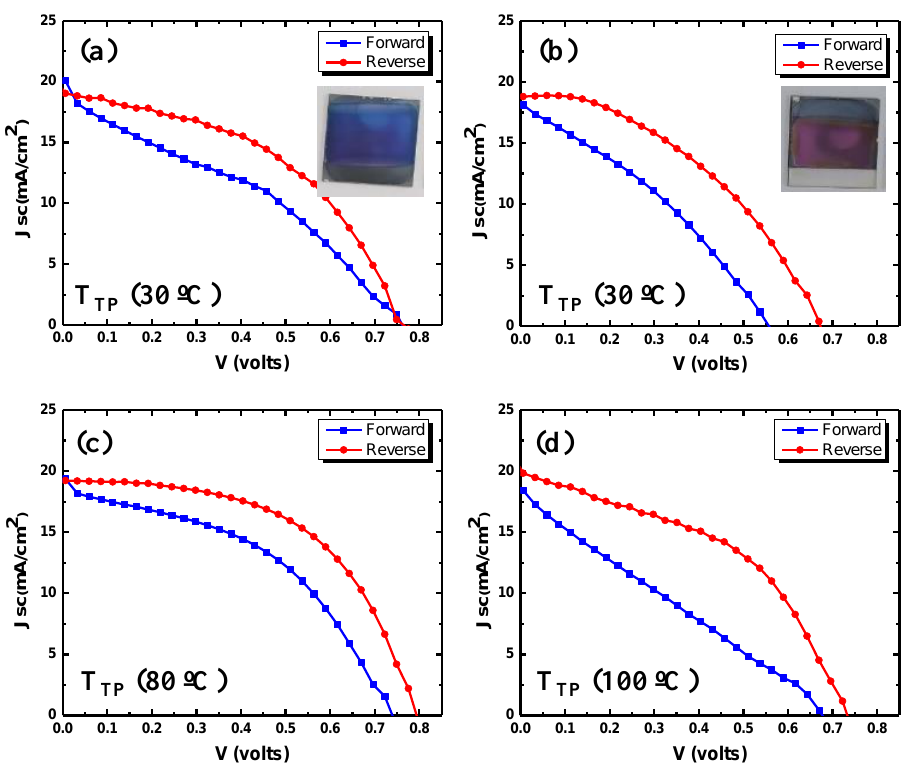
Figure 4. J–V curves for CuI HTL-based devices fabricated with iodization of ( a ) 20 and ( b ) 30 nm copper thin copper films (inset shows the laboratory-fabricated before-gold contact deposition). ( c , d ) devices fabricated using the iodization of 20 nm thin copper at transfer-printing pressure of 4 bar for 20 min at different transfer-printing temperatures, ( c ) 80 and ( d ) 100 °C. Table 1. Device parameters for CuI HTL-based devices fabricated with different thicknesses of cop- per films (t Cu ) and transfer-printing temperatures (T TP ).